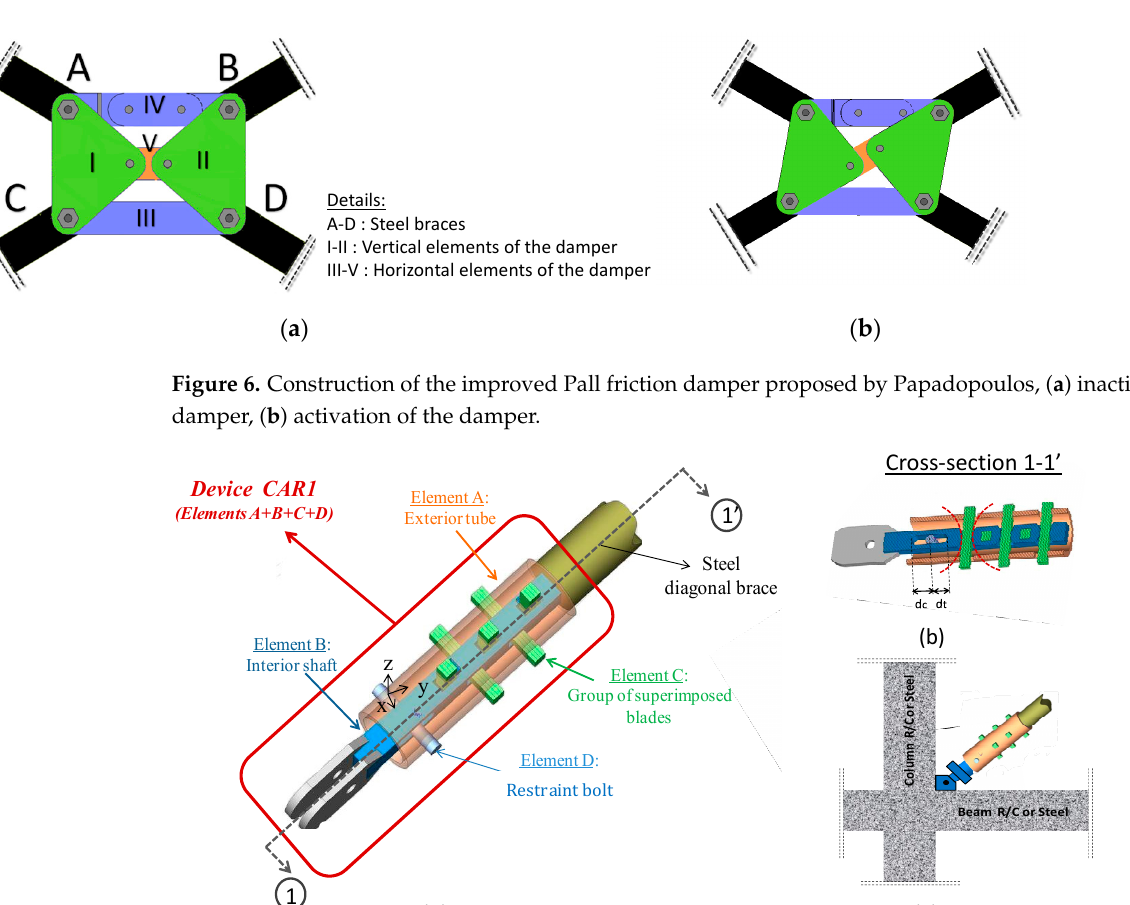
Figure 6. Construction of the improved Pall friction damper proposed by Papadopoulos, ( a ) inactive damper, ( b ) activation of the damper.